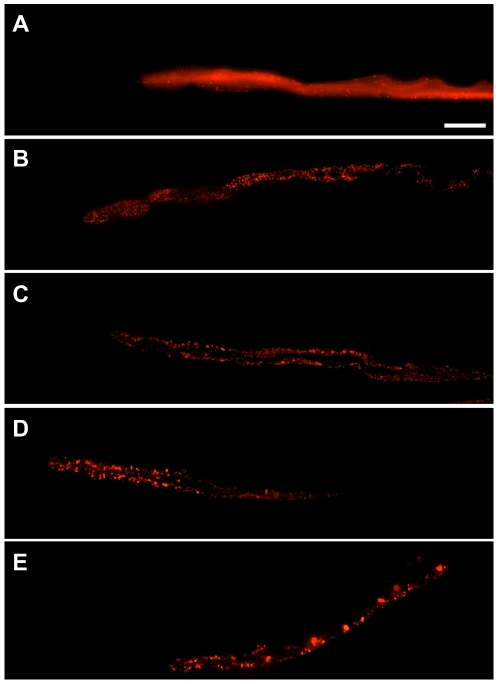
Induction of autophagy by hit compounds.Images of transgenic animals expressing Pnhx-2mCherry::lgg-1 treated with various compounds are shown. Images were acquired using a Nikon instruments TiEclipse widefield light microscope fitted with a 20× Plan Apochromat objective. Images were deconvolved using Volocity (Perkin Elmer, v 5.3.2). Deconvolved z planes were merged to a single plane. Well-fed animals treated with (A) DMSO show a diffuse mCherry expression throughout the intestine. In contrast, animals treated with (B) cantharidin, (C) fluphenazine and (D) pimozide show a markedly punctate distribution pattern indicative of increased autophagic activity. (E) Starved animals are included as a positive control for autophagy. Scale bar, 50 µm.